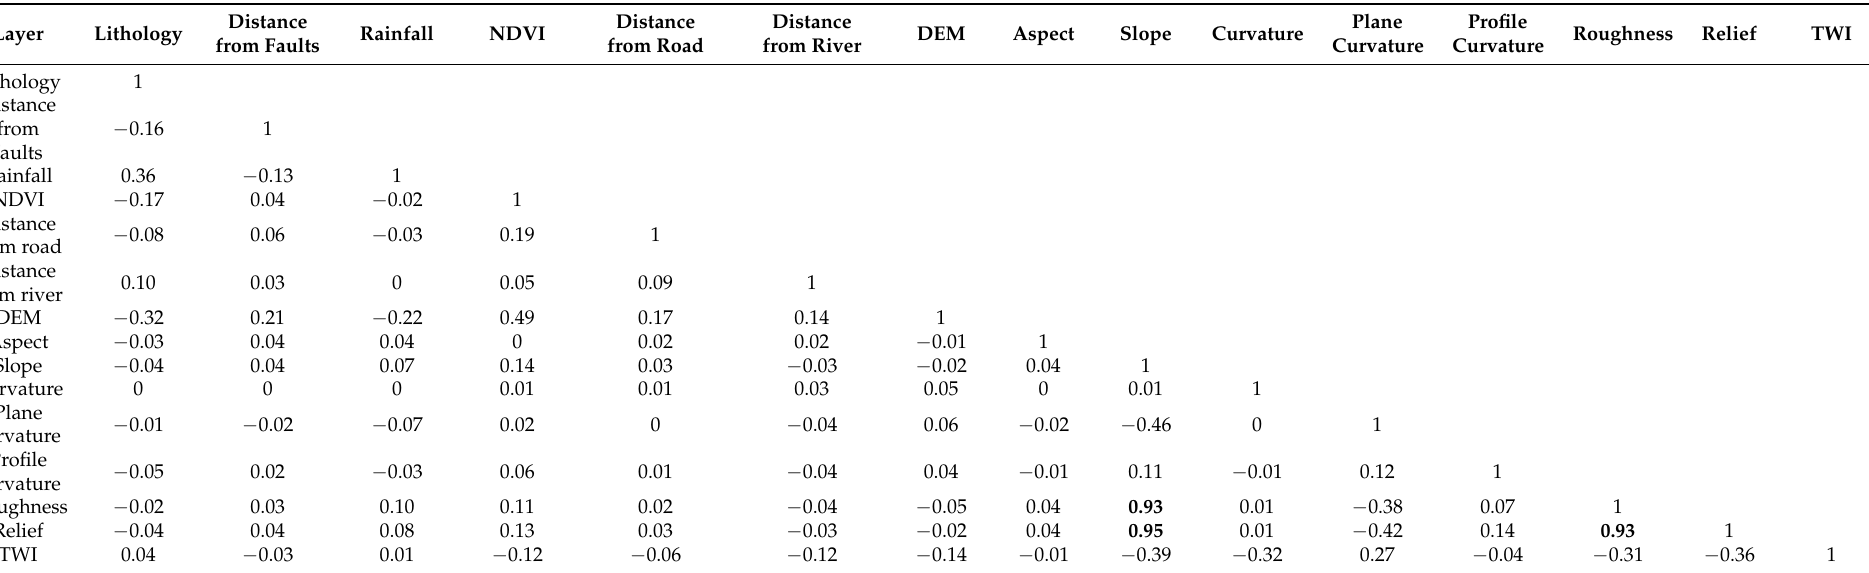
Table 5. Correlation Matrix (highly correlated values to be highlighted in